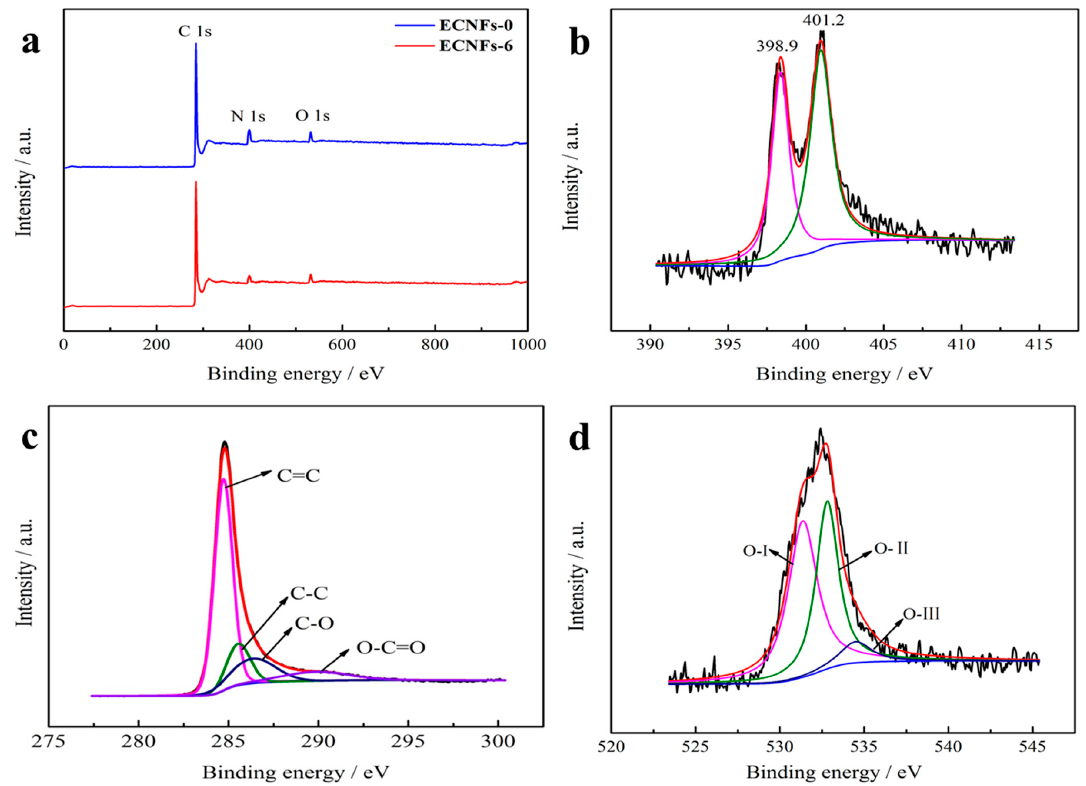
Figure 5. ( a ) XPS spectrums of ECNFs-0 and ECNFs-6; ( b ) C 1s peaks of ECNFs-6; ( c ) N 1s peaks of ECNFs-6; and ( d ) O 1s peaks of ECNFs-6.